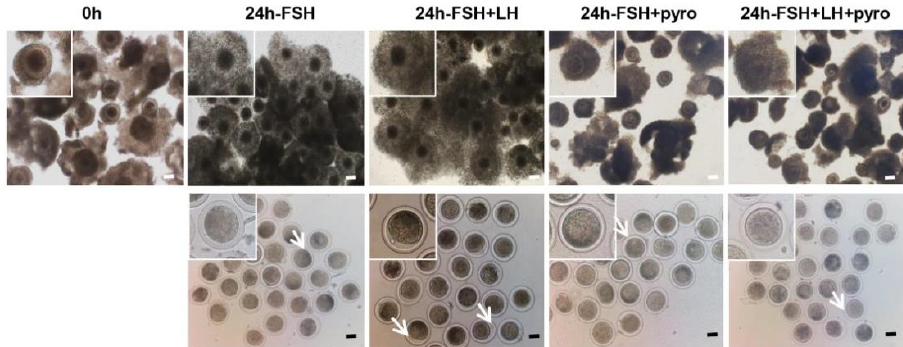
Figure 4. Inhibition of HDAC1 by pyroxamide affected the oocyte maturation in the in vitro-cultured model of COCs of Tan sheep. Schematic diagram of cumulus expansion and the first polar body. Note: Pyroxamide: HDAC1-specific inhibitor; 200 μ m scale. White arrows indicate the extrusion of the first polar body in the respective groups. n = 3. Table 1. Effect of the HDAC1 inhibitor on the cumulus expansion of oocytes ( n = 3). Group